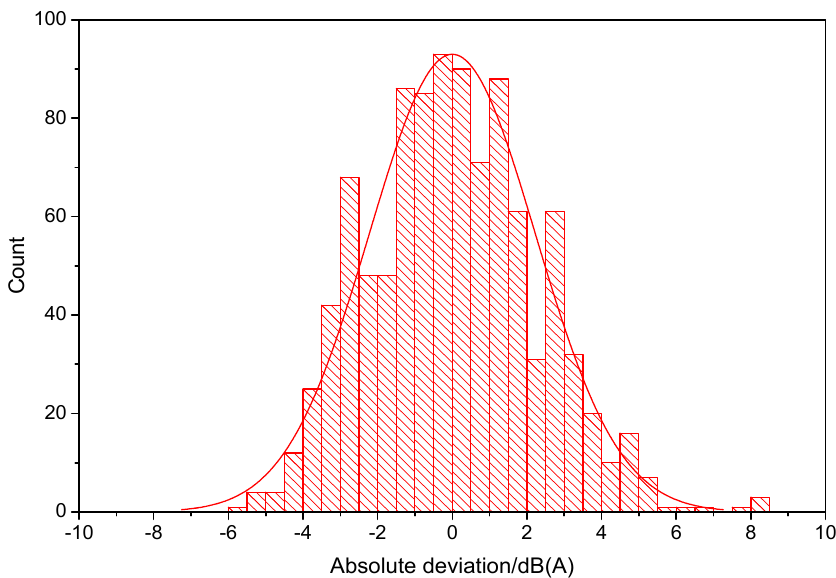
Figure 10. Absolute deviation of tested interior noise in different vehicles running in the same metro section.